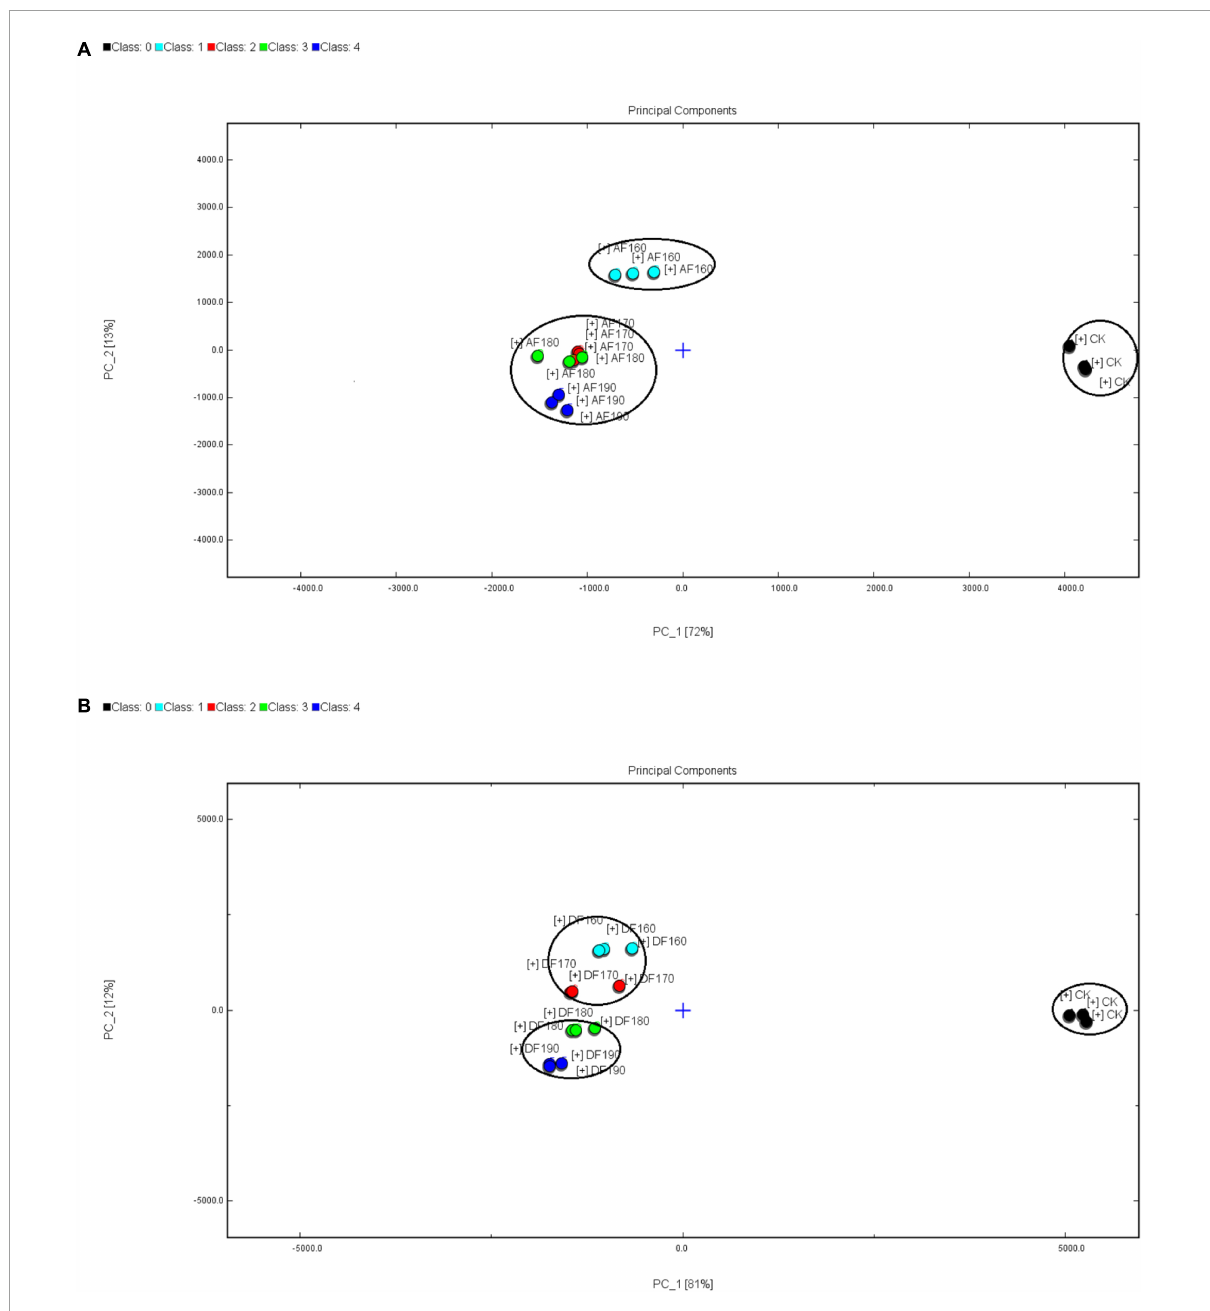
FIGURE5 Effect of frying temperature on the principal component analysis (PCA) of AFSM (A) and the principal component analysis (PCA) of DFSM (B) . DF, shrimp meat was treated with deep frying; AF, shrimp meat was treated with air frying; 160, 170, 180, 190: The fried temperature of shrimp meat is expressed as 160, 170, 180, and 190 ◦